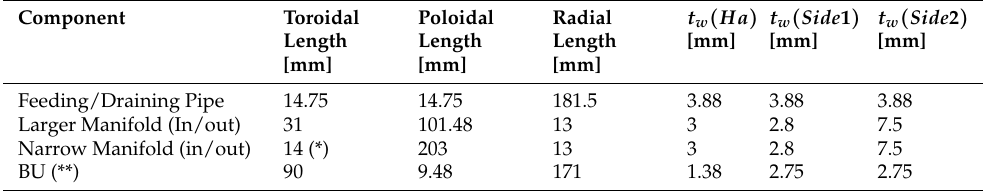
Table 12. Main geometrical parameters. (*) Average toroidal length of the narrow manifold along poloidal direction. (**) Cooling plates dimensions are not reported [33].